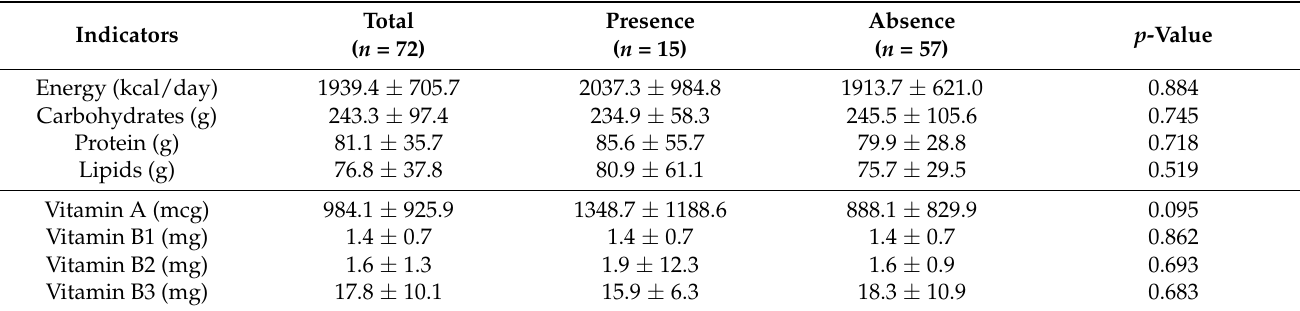
Table A6. Dietary characteristics regarding the waist-height